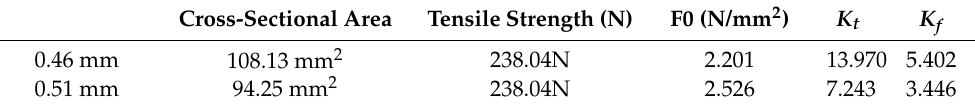
Table 4. Different fillet and corresponding